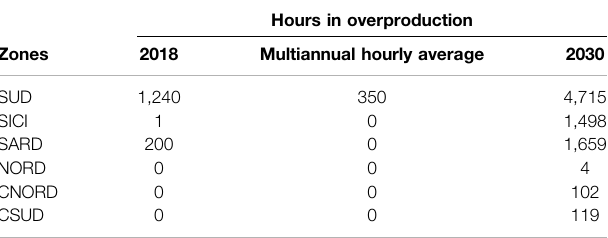
TABLE 3 | Summary of overproduction in different zones of the Italian electrical power system, according to TSO data and our projections. Hours in